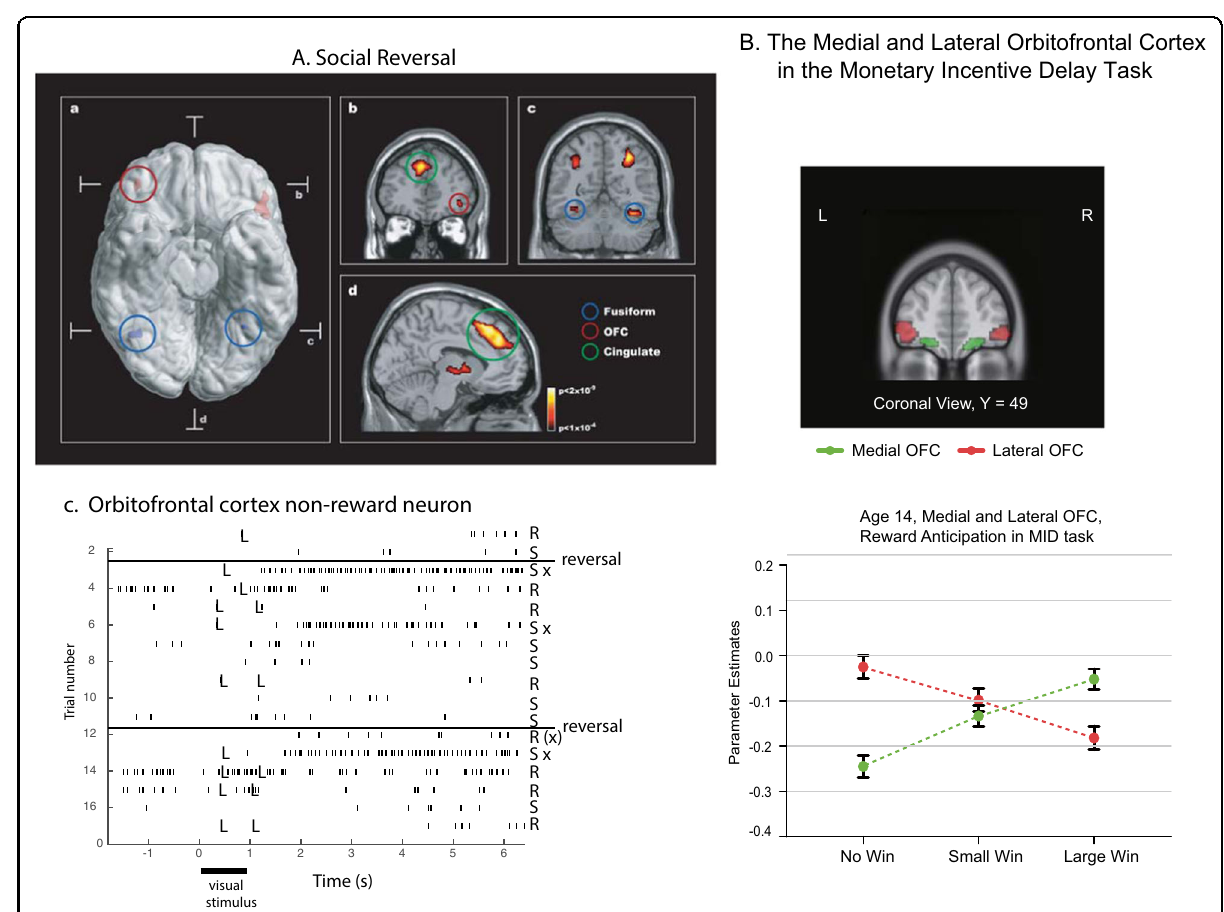
Fig. 7 Non-reward in the orbitofrontal cortex. A The human lateral orbitofrontal cortex is activated by non-reward in a visual discrimination reversal task on reversal trials, when a face was selected but the expected reward was not obtained, indicating that the participant should select the other face in the future to obtain the reward. a A ventral view of the human brain with an indication of the location of the two coronal slices ( b , c ) and the transverse slice ( d ). The activations with the red circle in the lateral orbitofrontal cortex (OFC, peaks at [42 42 – 8] and [ − 46 30 – 8]) show the activation on reversal trials compared to the non-reversal trials. For comparison, the activations with the blue circle show the fusiform face area produced just by facial expressions, not by reversal, which is also indicated in the coronal slice in ( c ). b A coronal slice showing the activation in the right orbitofrontal cortex on reversal trials. Activation is also shown in the supracallosal anterior cingulate region (Cingulate, green circle) that is also known to be activated by many punishing, unpleasant, stimuli (see Grabenhorst and Rolls 97 ) (From Kringelbach et al. 93 ). B Activations in the human medial orbitofrontal cortex (OFC) are related to Wins, and in the lateral orbitofrontal cortex to non-reward (No Win) in the monetary incentive delay task. The data are from 1877 participants aged 14 years, with similar results at age 19. (Modi fi ed from Xie et al. 96 ). C Non-reward error-related neurons maintain their fi ring after non-reward is obtained. Responses of an orbitofrontal cortex neuron that responded only when the macaque licked to a visual stimulus during reversal, expecting to obtain fruit juice reward, but actually obtained the taste of aversive saline because it was the fi rst trial of reversal (trials 3, 6, and 13). Each vertical line represents an action potential; each L indicates a lick response in the Go-NoGo visual discrimination task. The visual stimulus was shown at time 0 for 1 s. The neuron did not respond on most reward (R) or saline (S) trials but did respond on the trials marked S x, which were the fi rst or second trials after a reversal of the visual discrimination on which the monkey licked to obtain the reward, but actually obtained saline because the task had been reversed. The two times at which the reward contingencies were reversed are indicated. After responding to non-reward, when the expected reward was not obtained, the neuron fi red for many seconds and was sometimes still fi ring at the start of the next trial. It is notable that after an expected reward was not obtained due to a reversal contingency being applied, on the very next trial the macaque selected the previously non-rewarded stimulus. This shows that rapid reversal can be performed by a non-associative process, and must be rule-based. (After Thorpe et al. 92